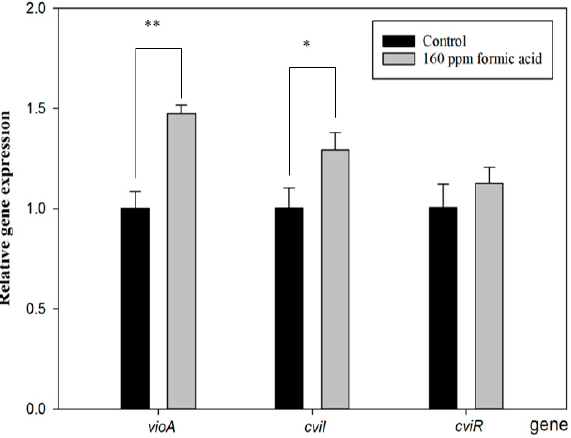
Figure 3. Effect of formic acid on ( A ) biomass and ( B ) violacein production of C. violaceum in bioreactor. Each value is expressed as mean ± standard deviation ( n = 3). Different superscripts are significantly different ( p < 0.05).